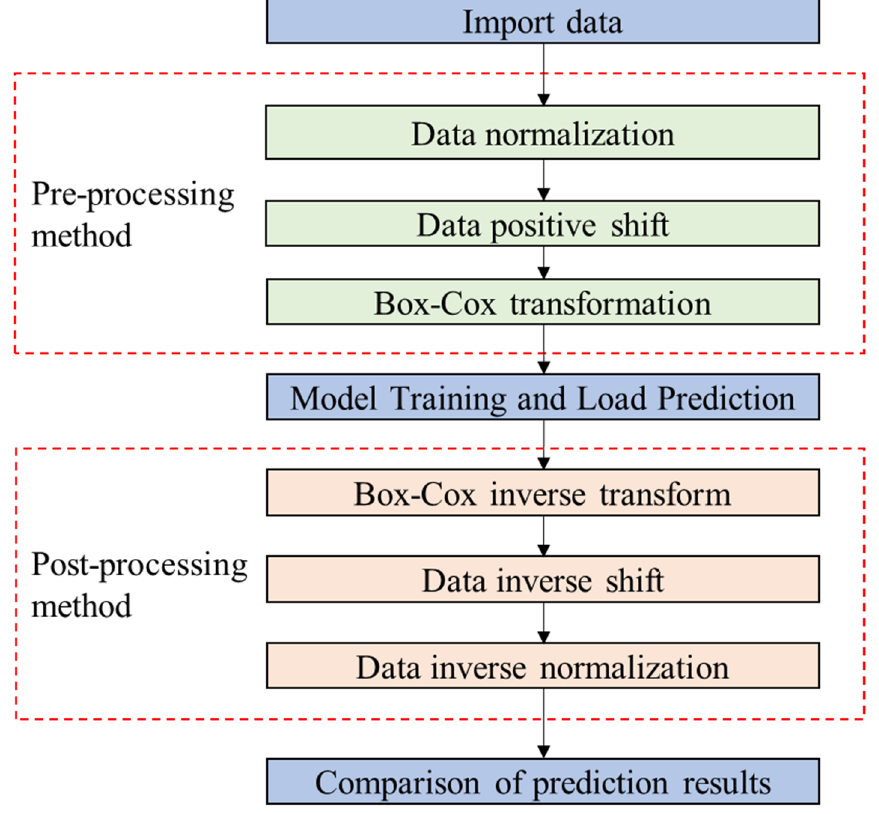
Figure 4. The flow of data processing method.